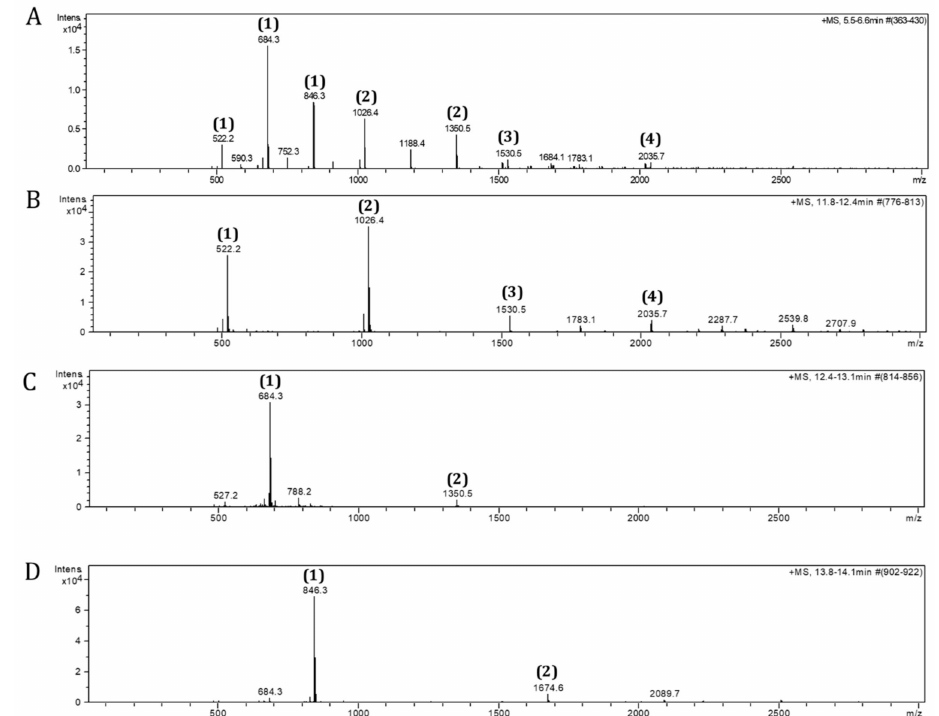
Figure 2. Electrospray ionization-mass spectrometry (ESI-MS) spectra of DP fractions. GOS DP oligomers were separated by size-exclusion chromatography from GOS mixture. The profiles of GOS DP3-5 ( A ), GOS DP3 ( B ), GOS DP4 ( C ), and GOS DP5 ( D ) are shown as ammonia adducts (1) = [M+NH 4 ] + , (2) = [2M+NH 4 ] + , (3) = [3M+NH 4 ] + , and (4) = [M+NH 4 ] +